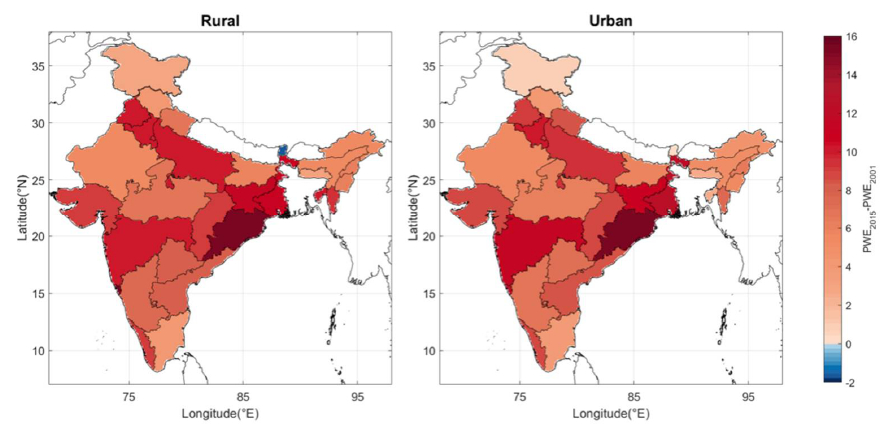
Figure 11. Changes (in µ g / m 3 ) in ( left ) rural and ( right ) urban population-weighted PM 2.5 exposure in 2015 relative to 2001 (shown in Figure 9).